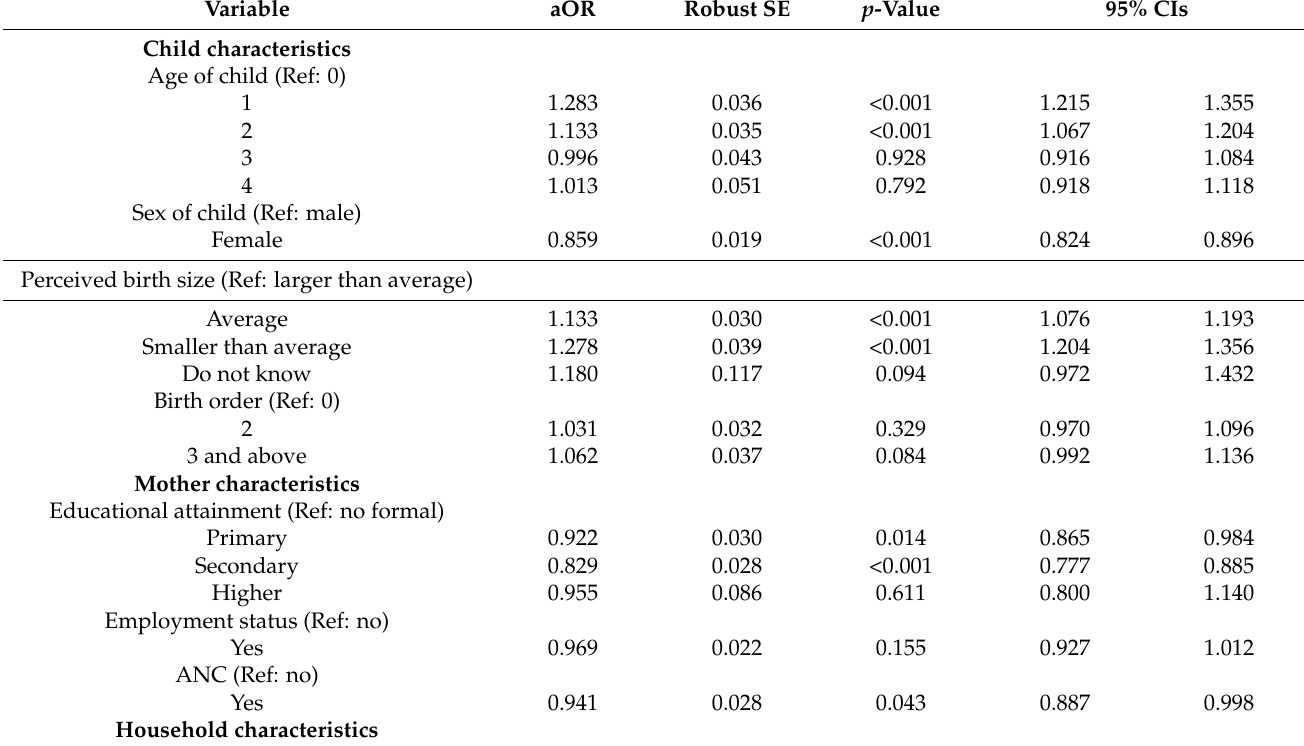
Table 3. Negative log-log regression showing relationships between TBM and predictor